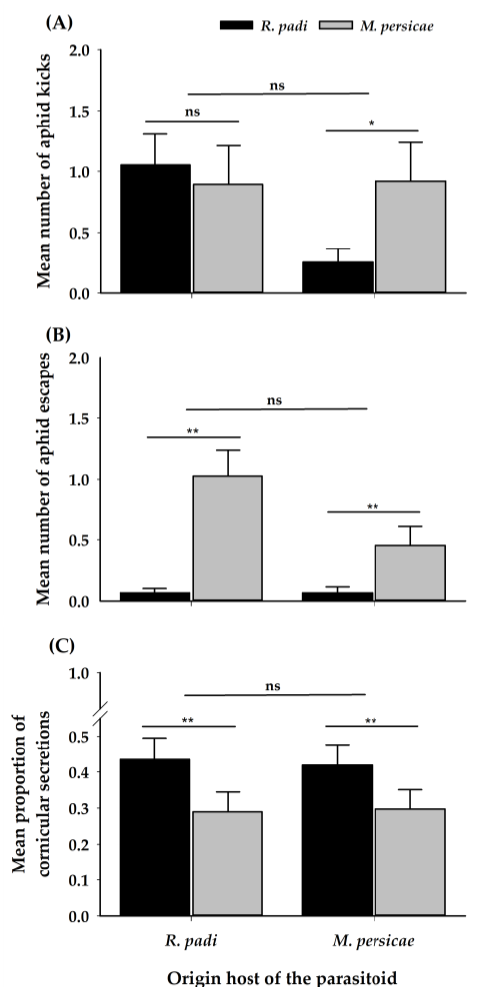
Figure 5. Mean ( ± SE) of aphid defensive behaviours: ( A ) Number of aphid kicks; ( B ) Number of aphid escapes and ( C ) Proportion of an encounter with cornicular secretions of R. padi and M. persicae when attacked by A. platensis coming from the two origins. Asterisks indicate significant differences: ‘***’ p < 0.001, ‘**’ p < 0.01 ‘*’ p < 0.05, ‘ns’ non-significant p > 0.05. Black and grey bars show the chosen/tested host.